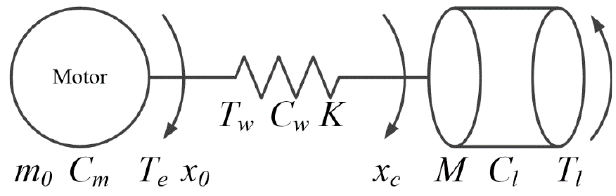
Figure 5. The transmission diagram.